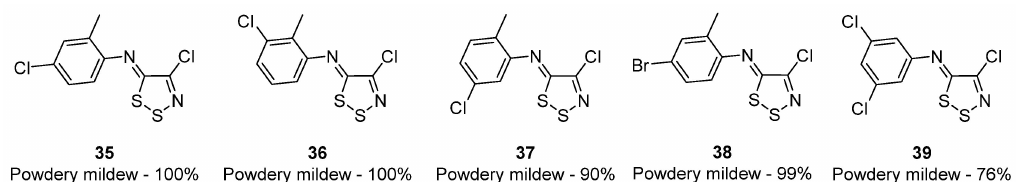
Figure 3. Antifungicidal activities of 1,2,3-dithiazoles against powdery mildew (250 ppm) and Botriytis cinerea (40